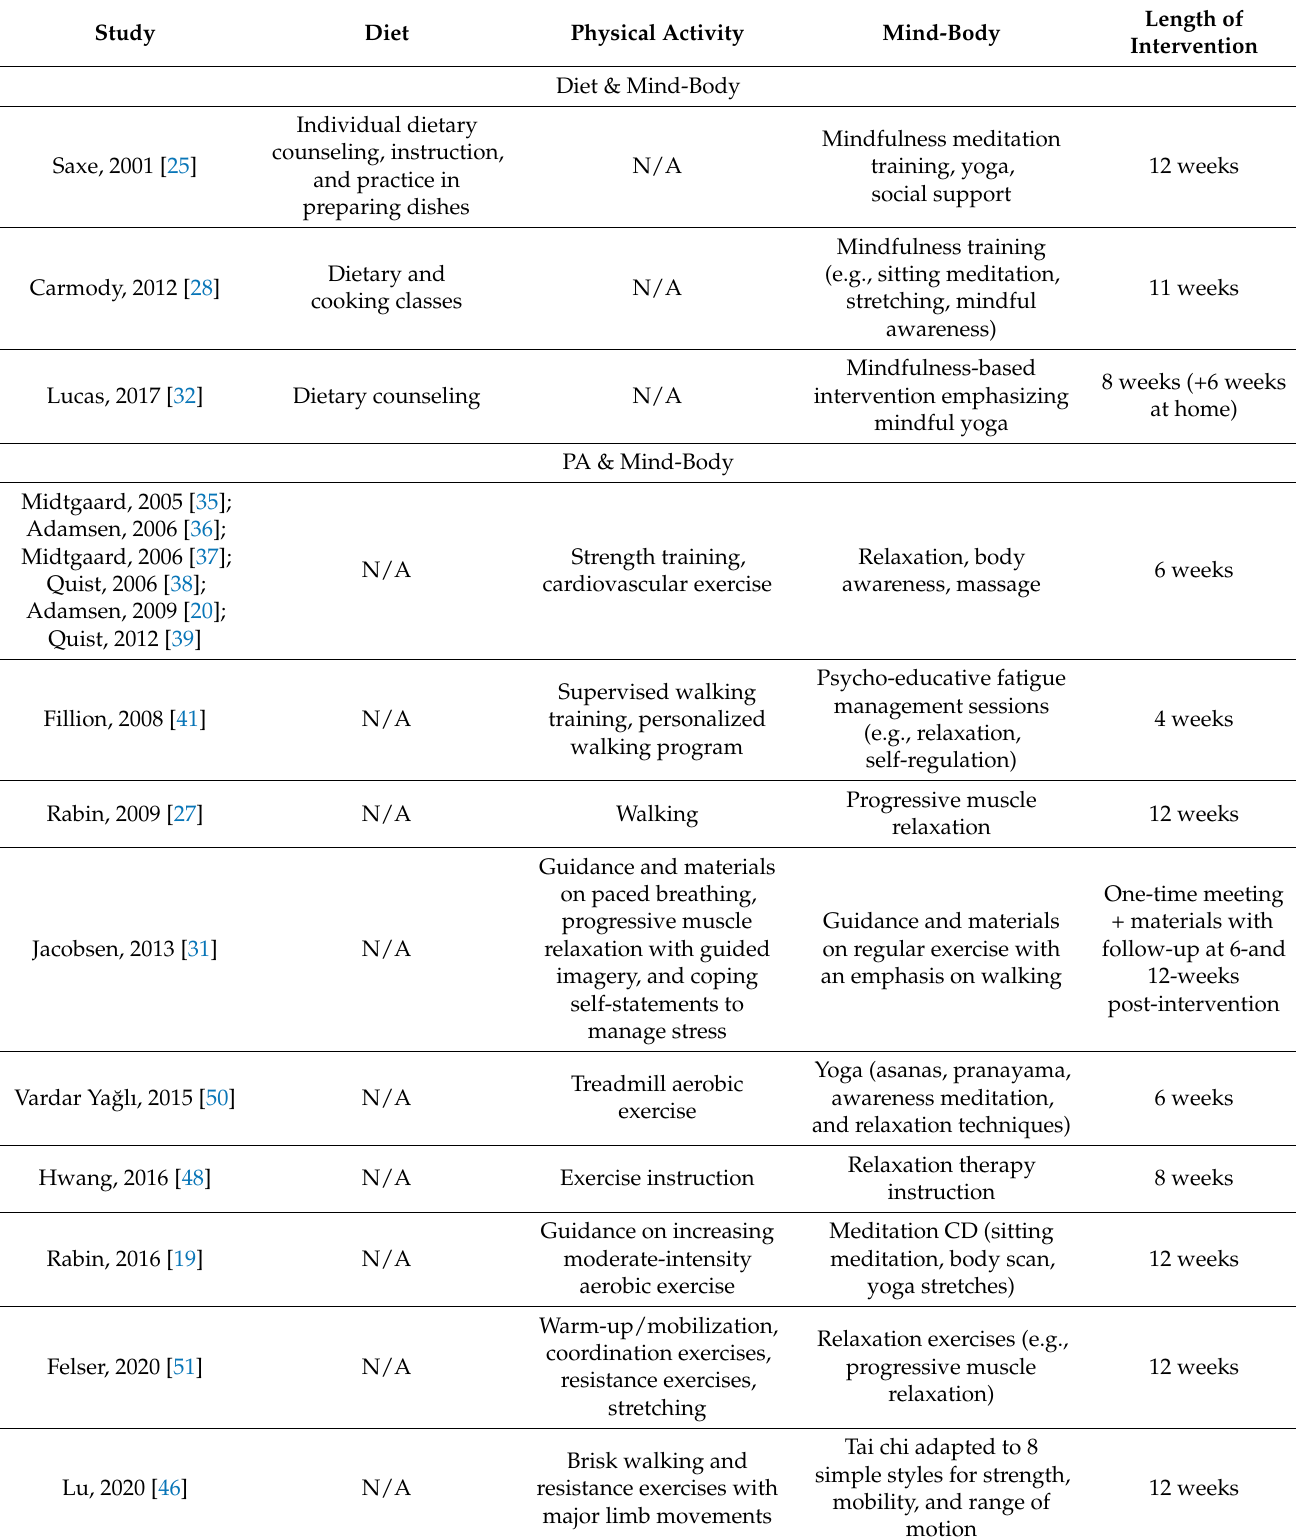
Table 2. Description of